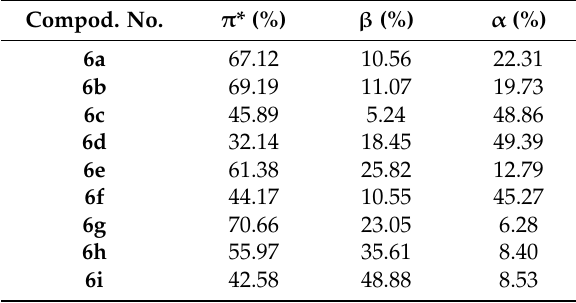
Table 6. Contribution percentages of solvatochromic parameters π *, β and α . Compod.